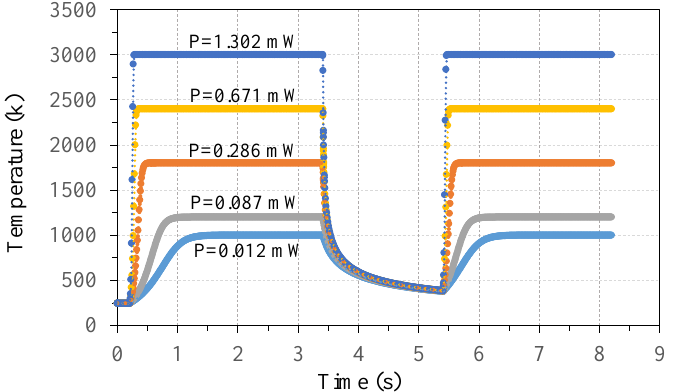
Figure 9. Simulation of thermal response of IR light source for different heating powers.